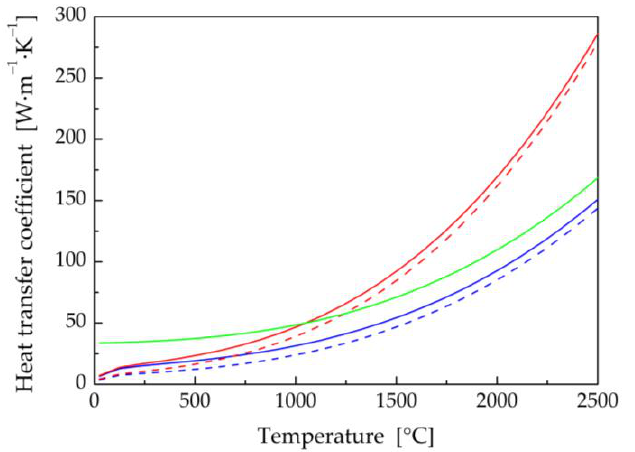
Figure 5. Calculated values of the combined heat transfer coefficient in dependence on the surface temperature of the welded sheets and the filler material. In the zone of filler material, cooling by forced convection and radiation was con- sidered (Figure 5). At an argon flow rate of 18 L · min − 1 , the convection heat transfer coefficient by forced convection was computed at the level of 33.2 W · m − 1 · K − 1 . At higher temperatures, the effect of radiation was again more